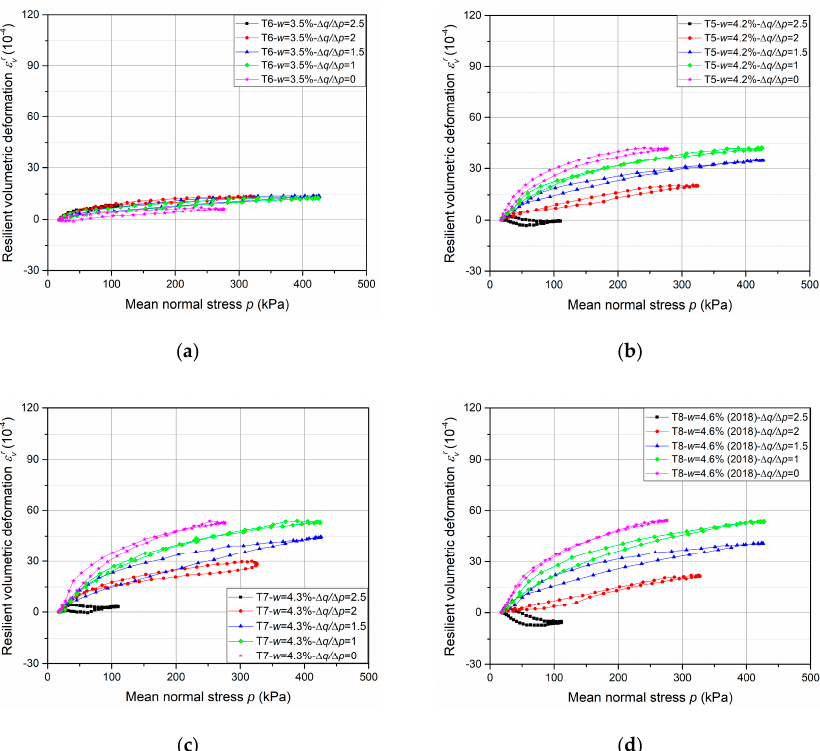
Figure 15. Resilient volumetric deformation ε vr at different water contents: ( a ) T6- w = 3.5%; ( b ) T5- w = 4.2%; ( c ) T7- w = 4.3%; ( d ) T8- w = 4.6%.